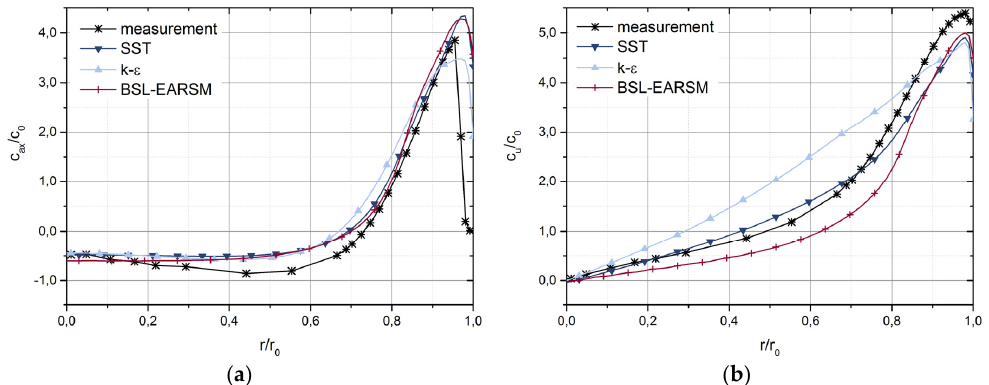
Figure 20. Comparison of axial ( c ax ) ( a ) and tangential ( c u ) ( b ) velocity profiles at the upper measurement section (L1) with the experimental velocity profiles at part load [10]; c 0 is the average velocity at the measurement plane.